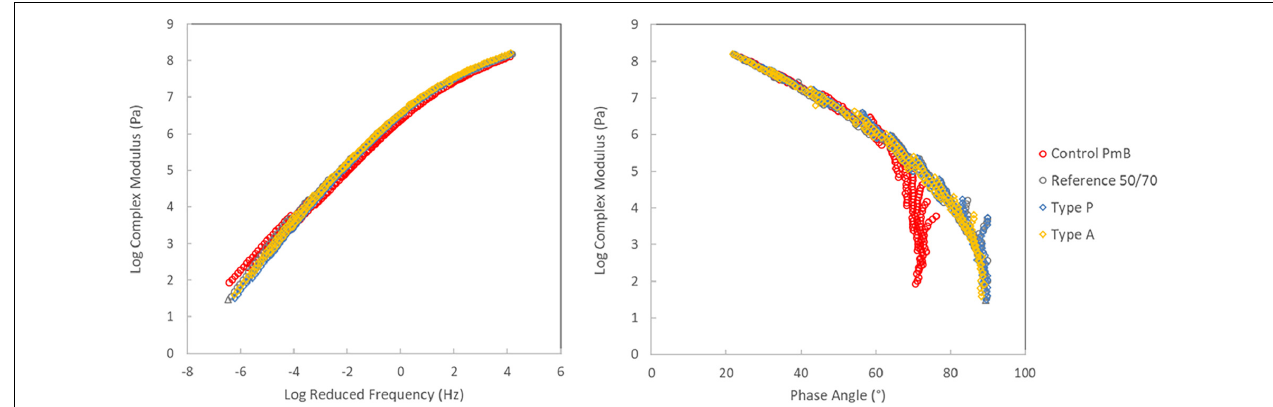
FIGURE 10 | Master curves (left) and Black curves (right) of the different bitumen samples after